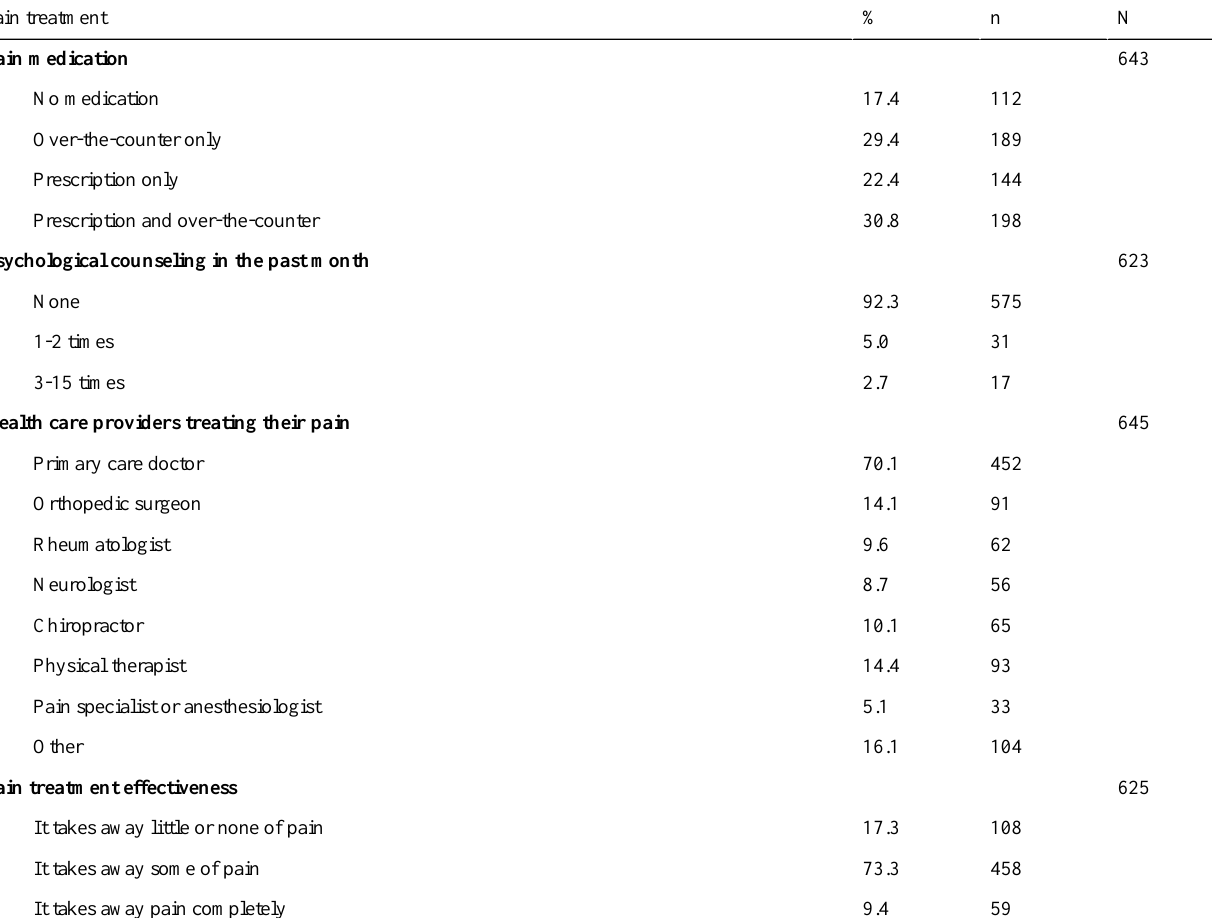
Table 2. Baseline self-reported pain treatments and pain management effectiveness